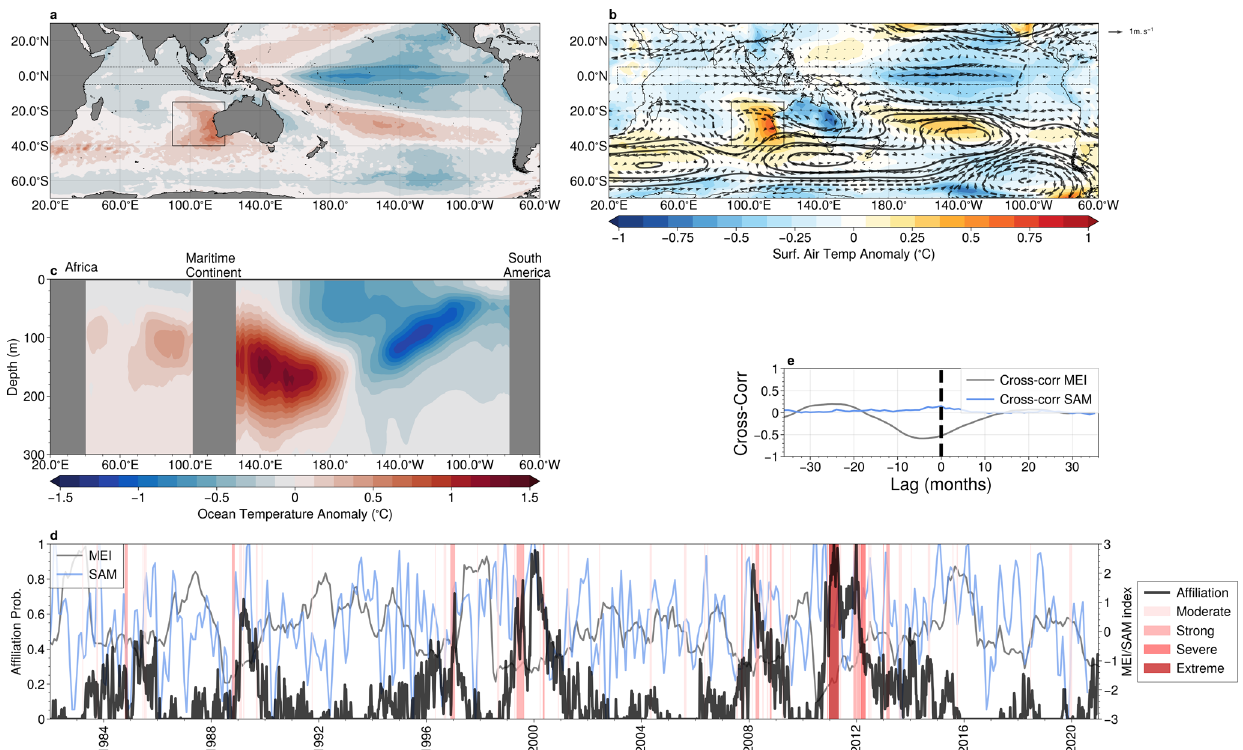
Fig. 4 | Teleconnections Associated with Marine Heat Waves in the South- eastern Indian Ocean. a Sea-surface temperature anomaly; b surface air tem- perature (colours) with anomalous mid-tropospheric (500hPa) geopotential height (contour lines, contour interval 5m) and winds (vectors); and c subsurface ocean temperatures (averaged latitudinaly between 5°S and 5°N within the region indicated by dashed lines in panels a and b associated with archetype #1. d The